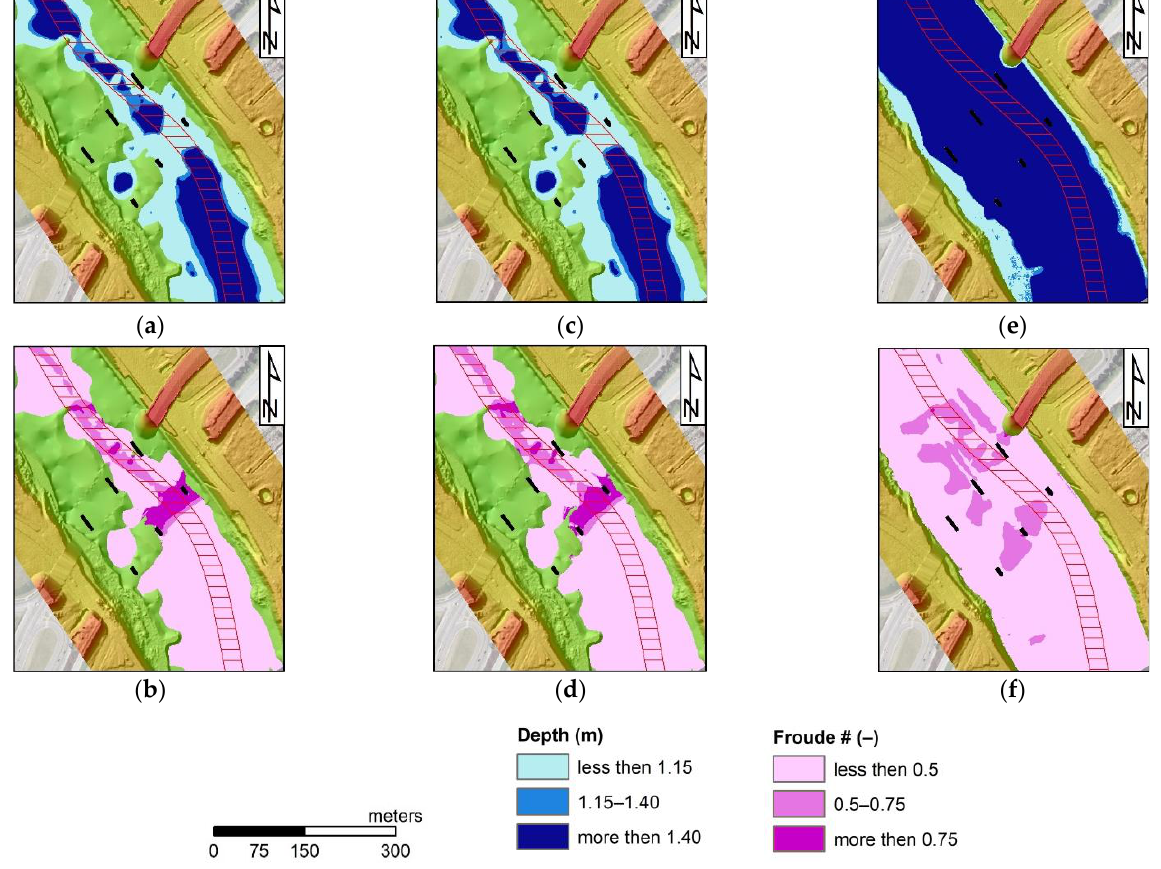
Figure 10. Results obtained for the roughness of the bottom equal to 0.015 s m − 1/3 : ( a ) map of depth classes for Q 95% , ( b ) distribution of Froude # for Q 95% , ( c ) map of depth classes for Q 95%,ice , ( d ) distribution of Froude # for Q 95%,ice , ( e ) map of depth classes for Q 50% , ( f ) distribution of Froude # for Q 50% .